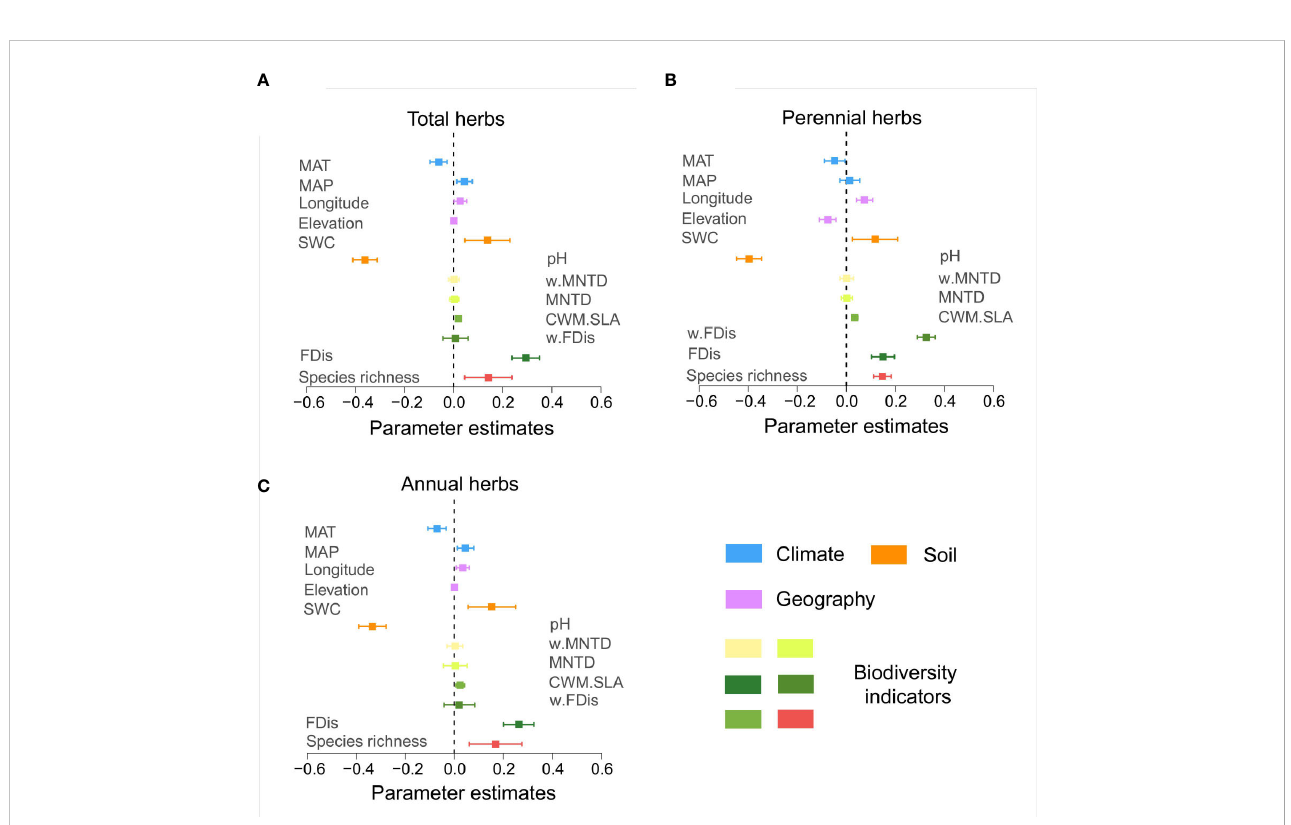
FIGURE 4 Standardized regression coef fi cients and associated 95% con fi dence intervals for the multifunctional model predictor variables. Standardized regression coef fi cients were derived from the model averaging procedure and averaged over the threshold range (0-100%). Con fi dence intervals that do not cross the zero line indicate that the predictor variables considered are associated with a statistically signi fi cant ( p < 0.05). See Table S3 for the mean thresholds of the standardized regression coef fi cients for each predictor variable. ( A , total herbs; B , perennial herbs; C , annuals